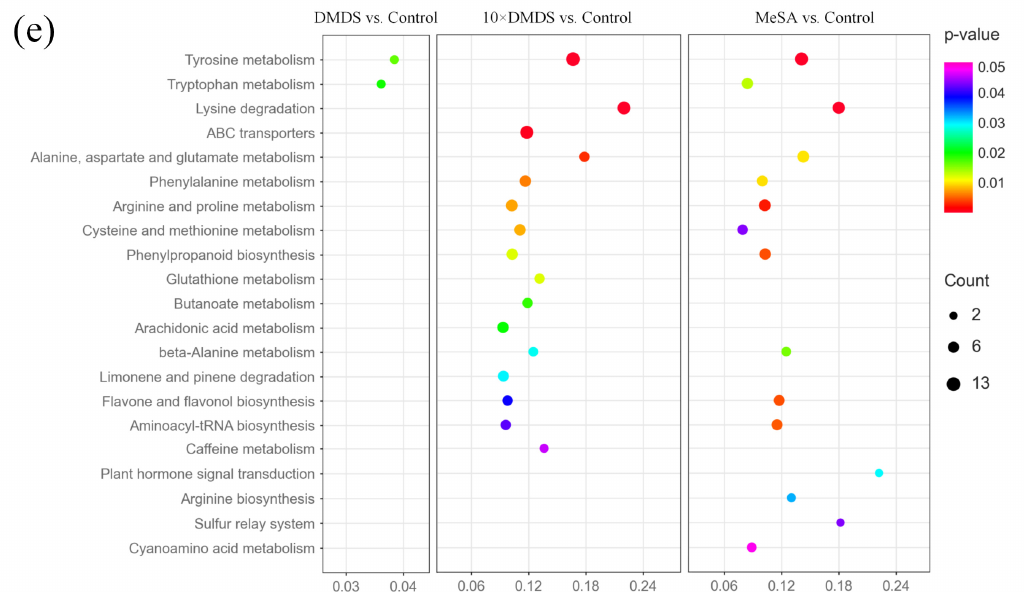
Figure 7. Characterization of the differentially expressed semipolar metabolites (DEMs) of orange plants after exposure to dimethyl disulfide (DMDS). ( a ) PLS-DA (score plot); and ( b ) clustering analysis and heat map of expression measures of semipolar metabolites. ( c ) The number of DEMs in different groups (for details, see Supplementary Table S2). ( d ) Venn diagram showing the distribution and overlap of up- and downregulated DEMs across all treatments. ( e ) KEGG pathway enrichment of DEMs.